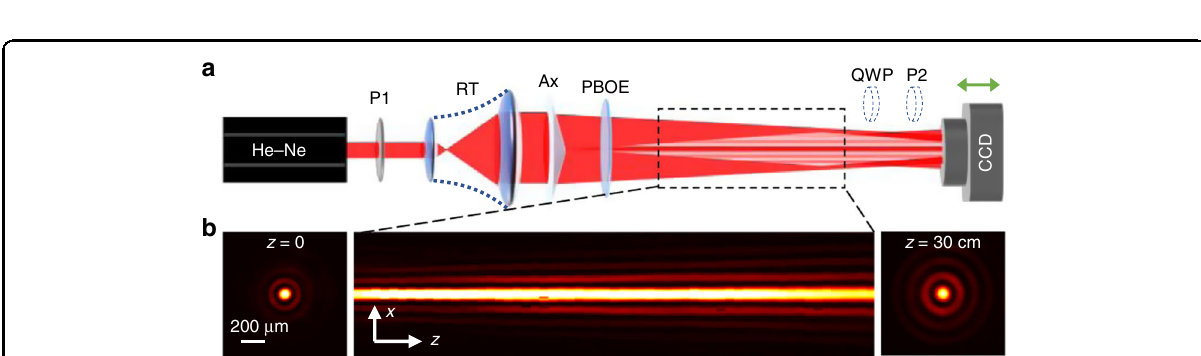
Fig. 3 Experimental setup for observing the oscillated PSHE. a Schematic of the setup. P, polarizer; RT, reversed telescope; Ax, axicon; QWP, quarter-wave plate. b Intensity distributions (left, right) and the side view of the beam propagation (middle) of the generated zero-order Bessel